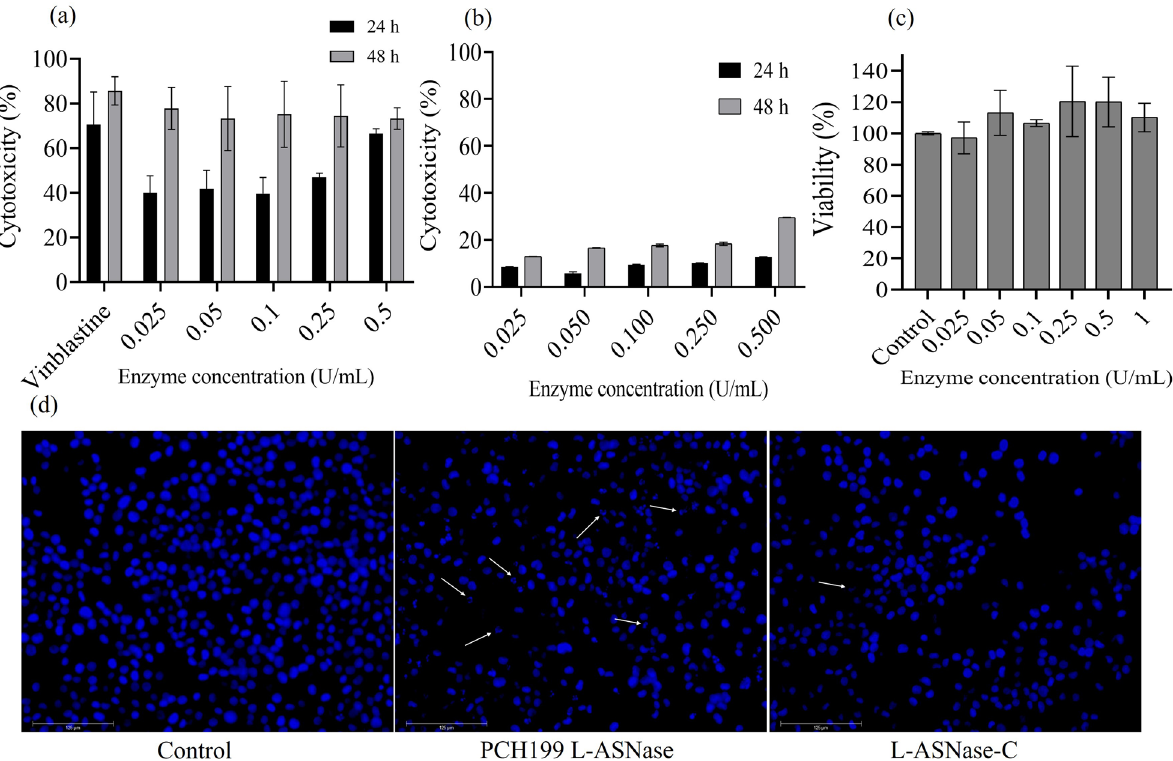
Fig. 6 Cytotoxicity evaluation of purified L-ASNase against cancer cell lines. a Cytotoxic effect of purified L-ASNase from PCH199. b E. coli L-ASNase (Elspar) on K562 blood cancer cell line using MTT assay. c The cytotoxic effect of L-ASNase was also tested towards normal cancer cell line IEC-6. d DAPI staining. Treated cells stained with DAPI clearly showed DNA fragmentation. Control cells showed uniform, rounded nuclei. L-ASNase-C indicates E. coli